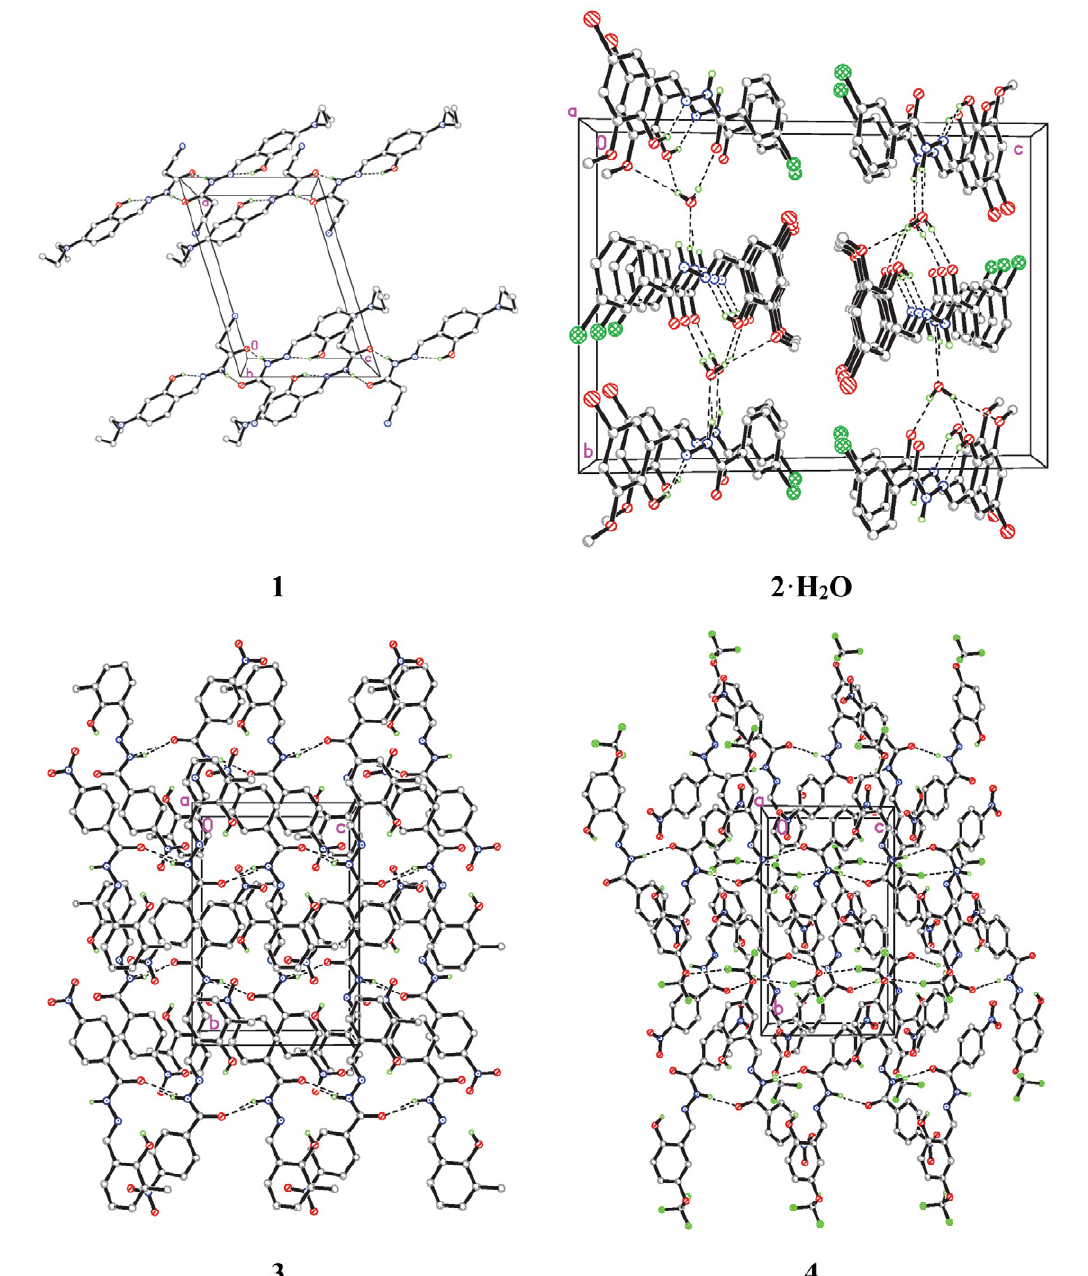
Figure 2. Molecular packing diagrams of the compounds 1 – 4 . Hydrogen bonds are shown as dashed